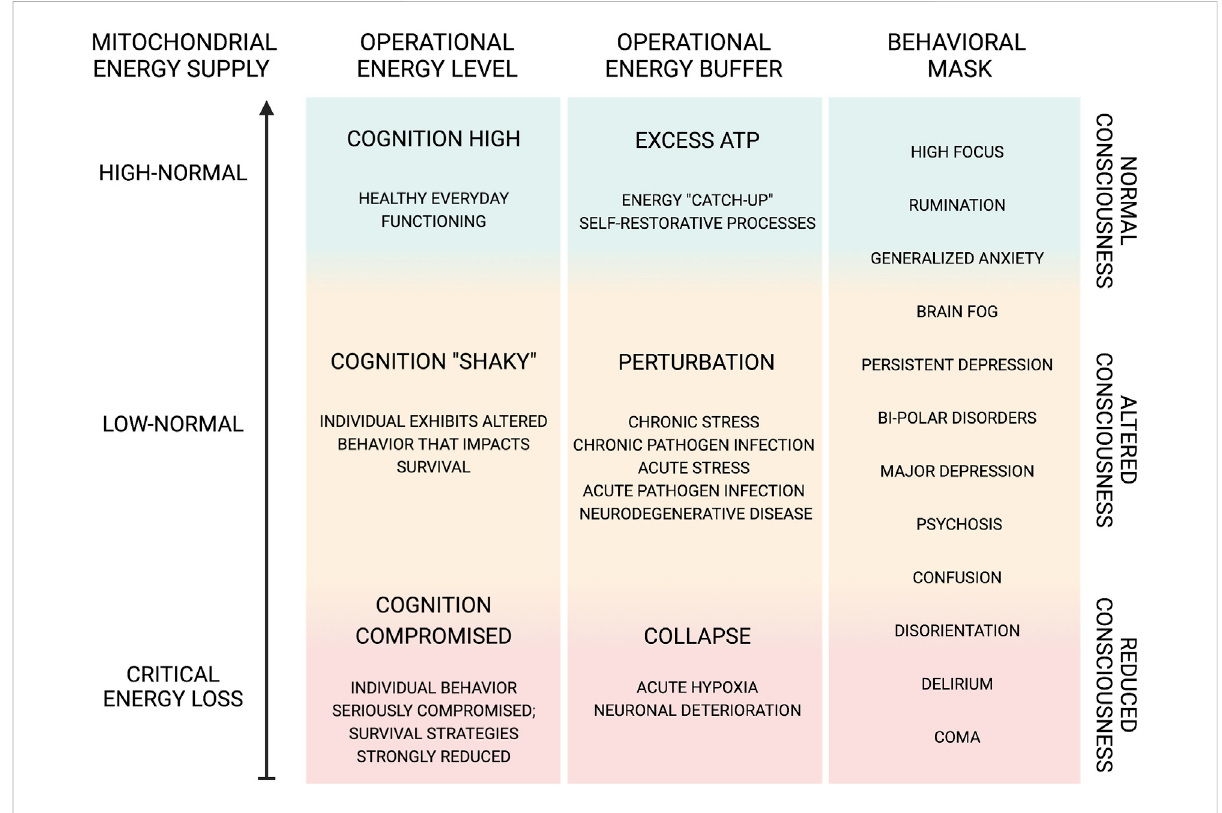
FIGURE 3 Dynamic functional range of cognition and